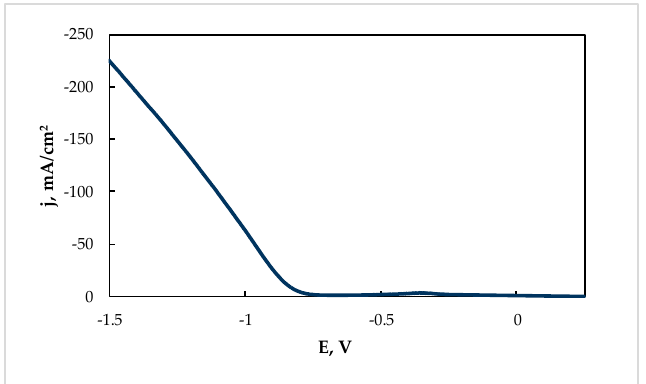
Figure 4. Cathodic polarization curve of Sn electroreduction at 60 °C from the “Ref” solution (g/L): Sn(II)—20; citric acid—200.